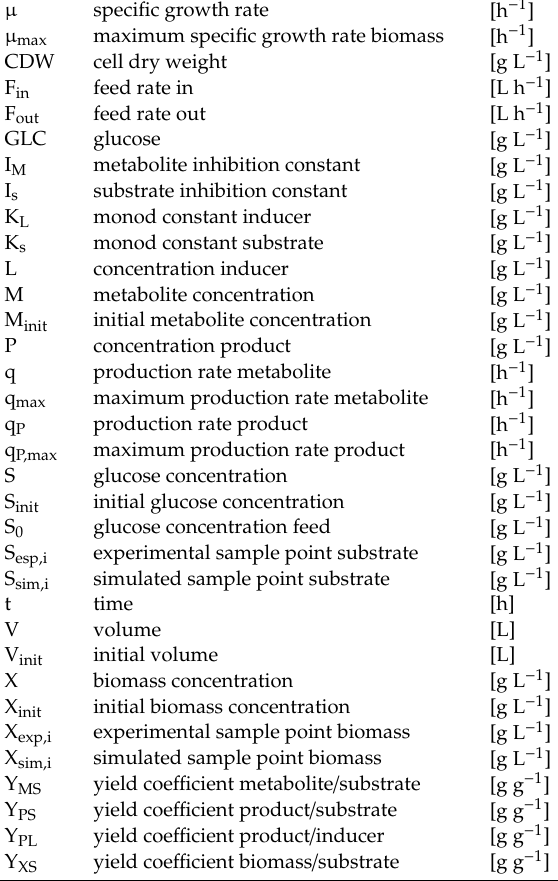
Table A2. List of